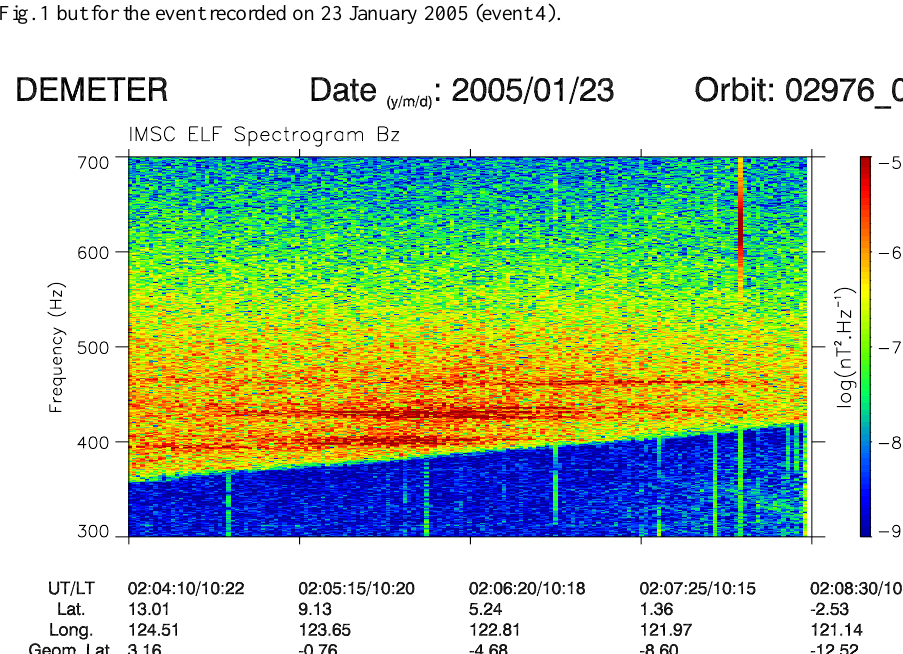
Fig. 8. Enlarged spectrogram between 0 and 700Hz related to the data shown in the top panel of Fig.